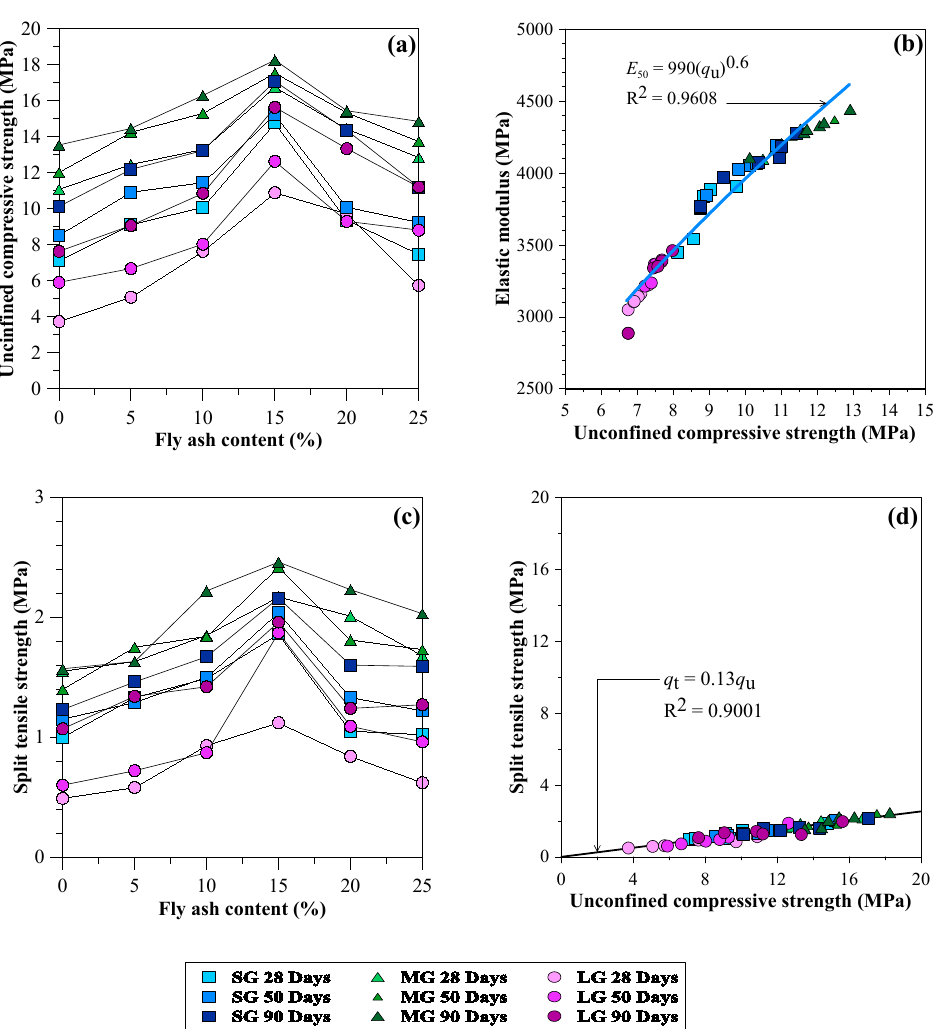
Figure 11. Relationships of ( a ) unconfined compressive strength versus fly ash content, ( b ) relation- ship of elastic modulus and unconfined compressive strength, ( c ) splitting tensile strength versus fly ash content, ( d ) relationship of splitting tensile strength and unconfined compressive strength .